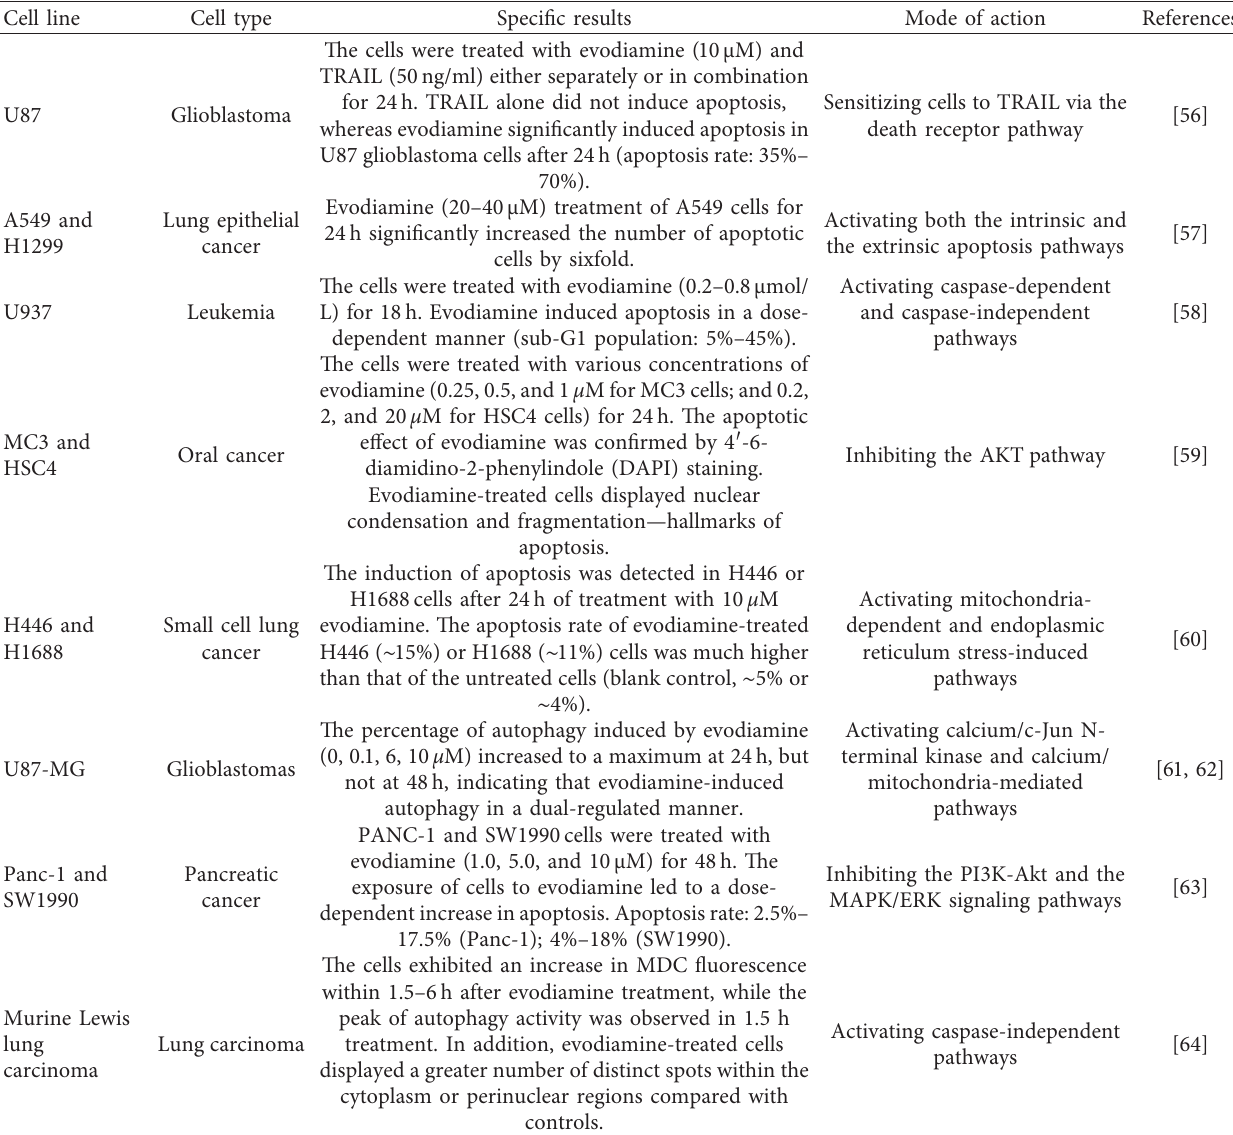
Table 3: Induction of apoptosis and autophagy by evodiamine in cancer cell lines in vitro. Cell